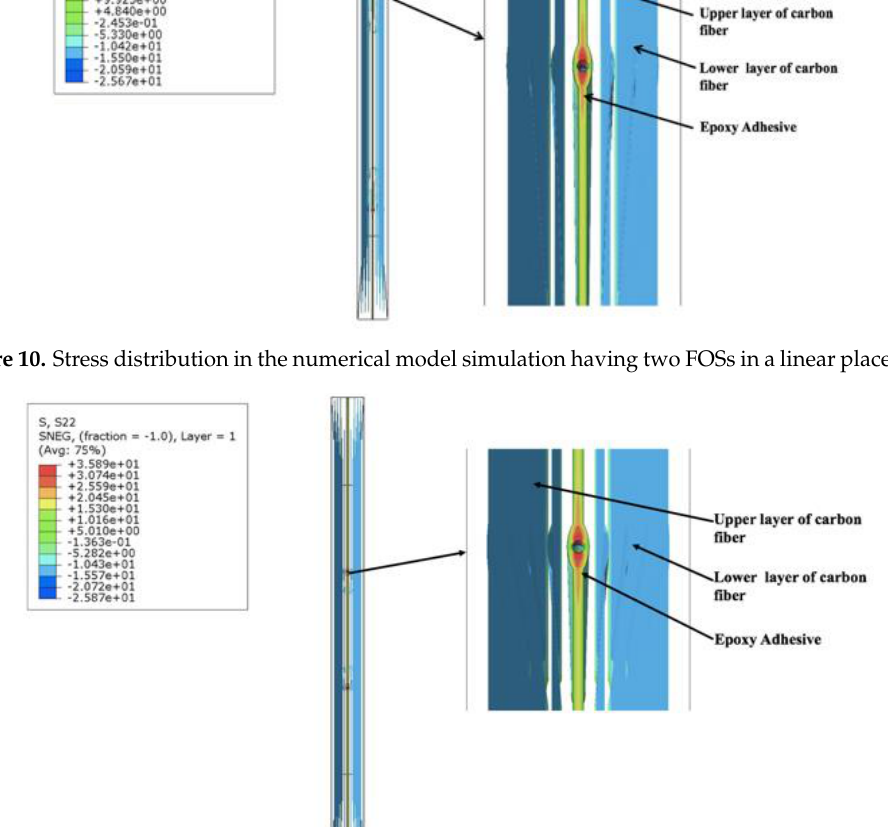
Figure 12 . Comparison between three different multi-linear FOSs placements. The green coloured graph shows the stress variation in the numerical model having three fibers. It shows that the stress is maximum (35.27 MPa) at the near FOS in the epoxy and then it decreases with the distance between two adjacent fibers. It is clearly seen that there is a fluctuation of stress values from 22.23 MPa to 20.10 MPa in between the FOSs when they are placed at a distance of 75 mm from each other. Also, the stress value calculated from the edge of specimen to the first FOS, which is at a distance of 75 mm, rises to 19.31 MPa and then settles down around 19 MPa. When the blue graph is